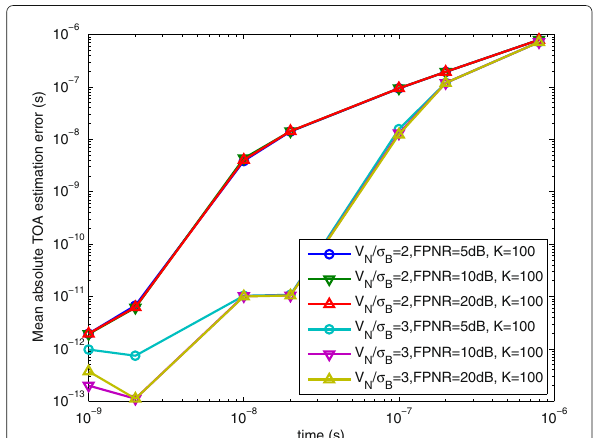
Fig. 8 TOA estimation error for low V N /σ B with FPNR as parameter